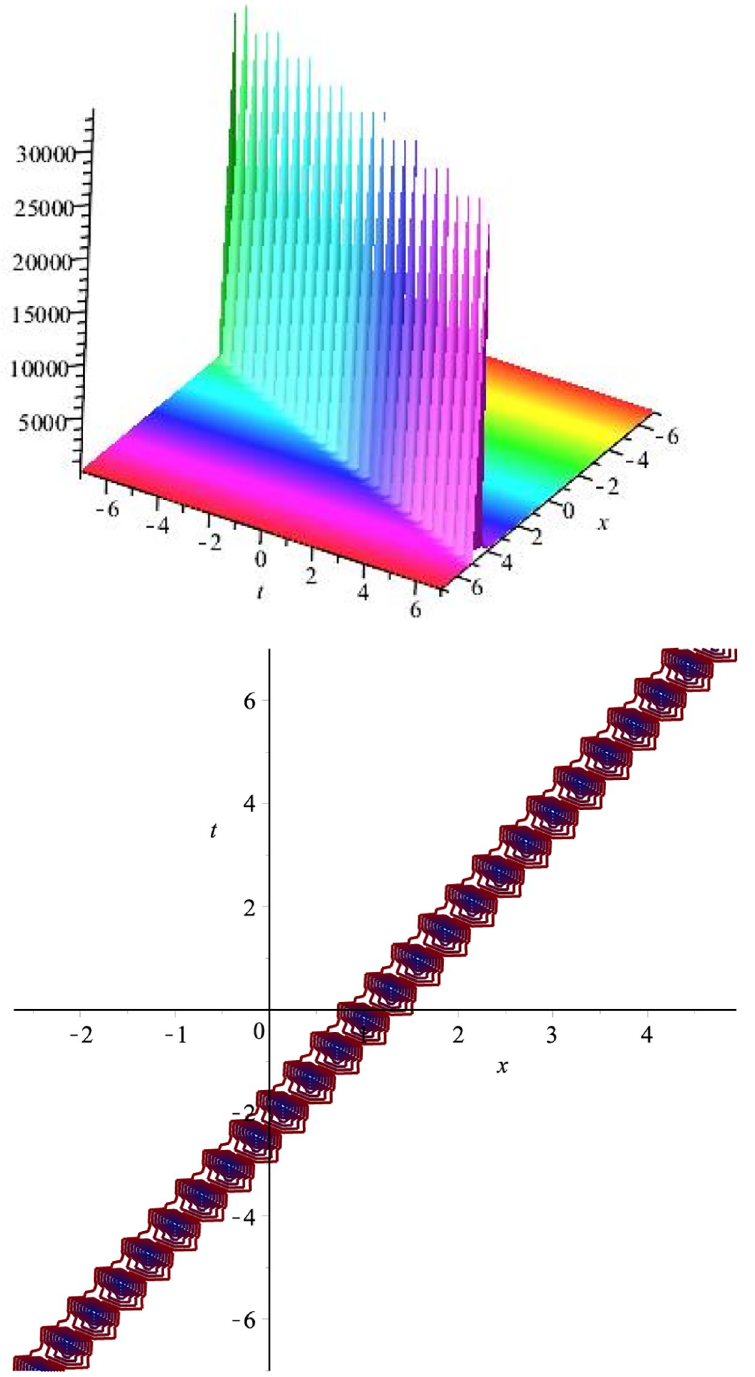
Fig 2. Singular soliton: j v 2 ( x , t ) j for l = 0.67, m = 2.1, λ = 1.5, c = − 1.4, v = 0.5, μ = 2.5.